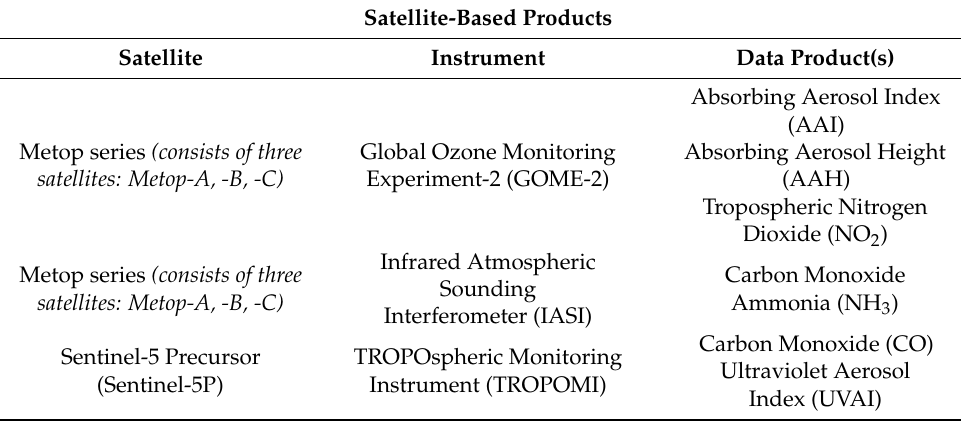
Table A1. Overview of satellite- and model-based products featured in the LTPy main